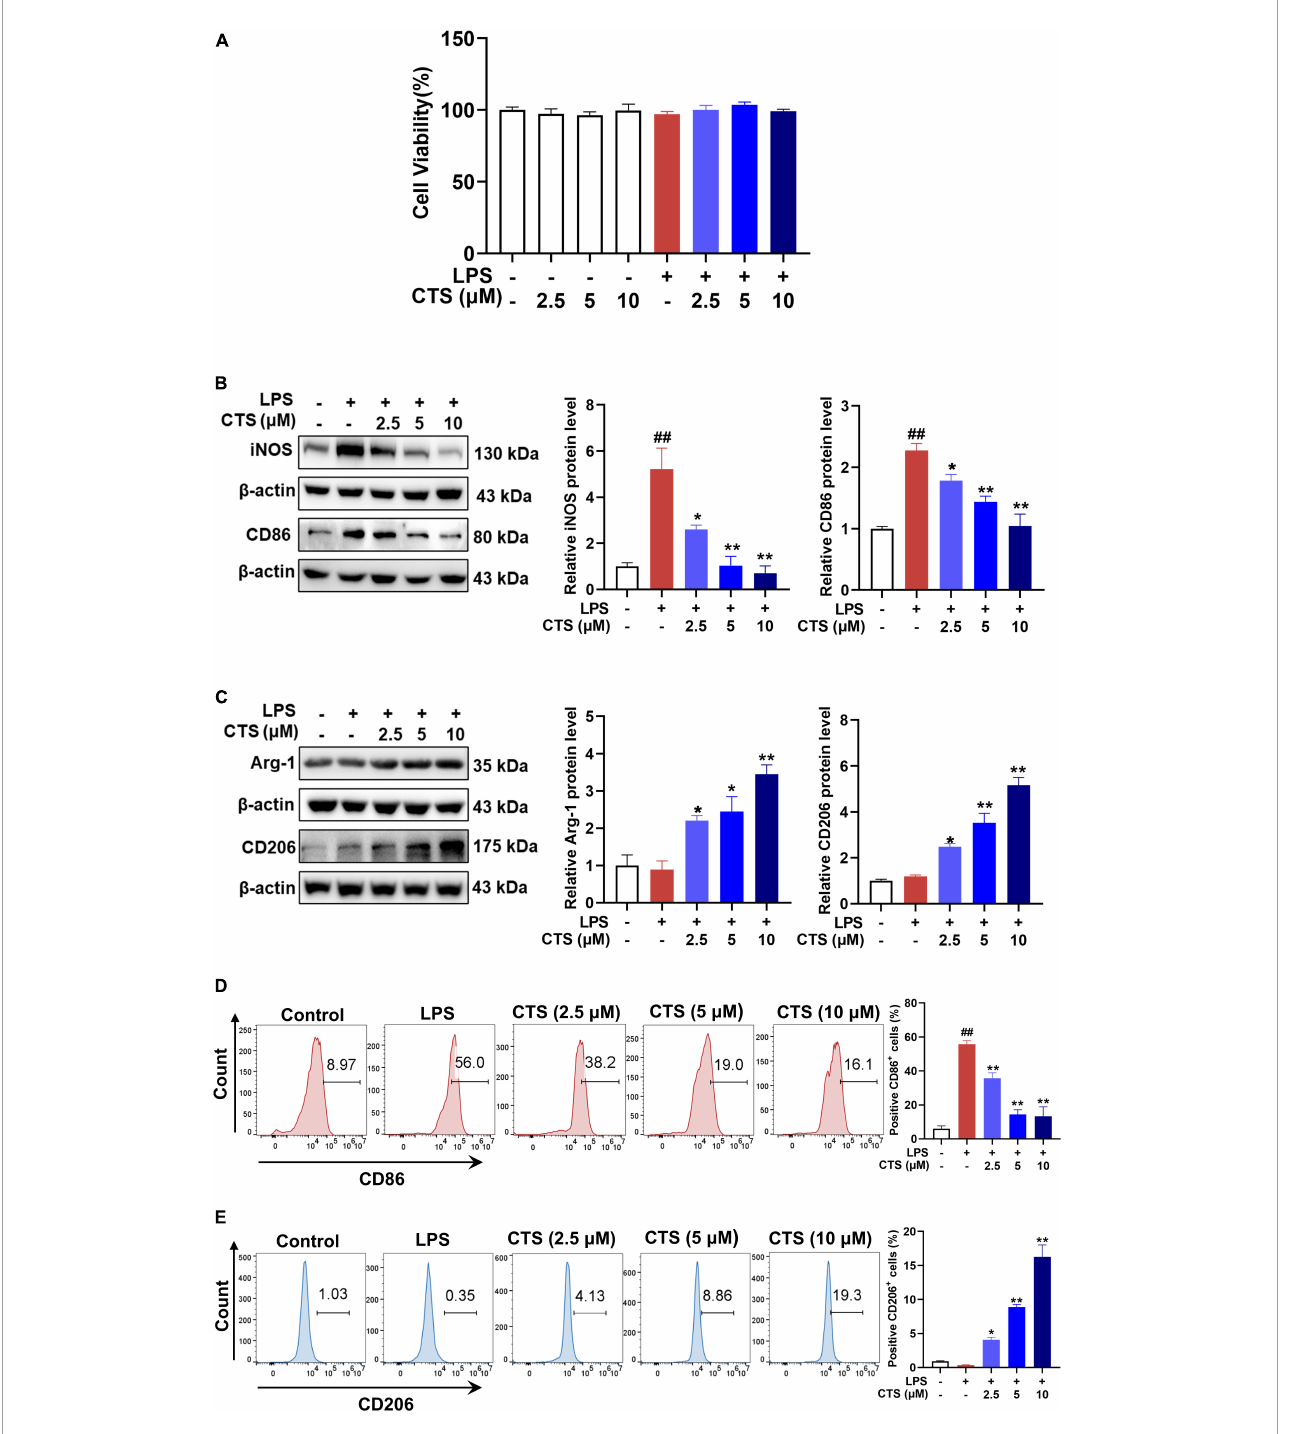
FIGURE3 Cryptotanshinone (CTS) inhibited M1-type polarization and promoted M2-type polarization of RAW264.7 macrophages. (A) CTS alone or co-treatment with or without LPS stimulation and cell viability was measured. RAW264.7 were pretreated with CTS (2.5, 5, and 10 µ M) for 2 h and then co-stimulated with LPS (1 µ g/mL) for another 24 h. (B) The protein expression of iNOS and CD86, n = 3. (C) The protein expression of Arg-1 and CD206, n = 3. (D) The proportion of CD86 positive cells was analyzed by flow cytometry, n = 3. (E) The proportion of CD206 positive cells was analyzed by flow cytometry, n = 3. Data were presented as the mean ± SEM. ## P < 0.01 vs. the control group; * P < 0.05, ** P < 0.01 vs. the LPS